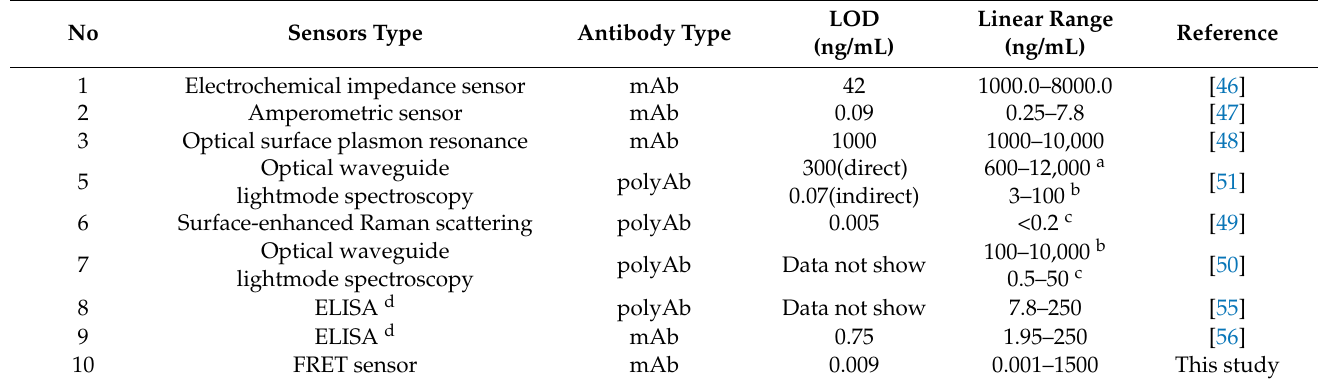
Table 1. Comparison the LODs and test ranges for various immunosensing methods for Vtg/ Lv